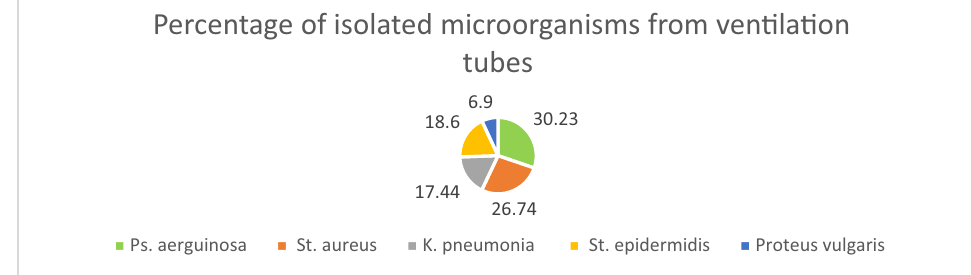
Figure 1: Percentage of isolated microorganisms from ventilation